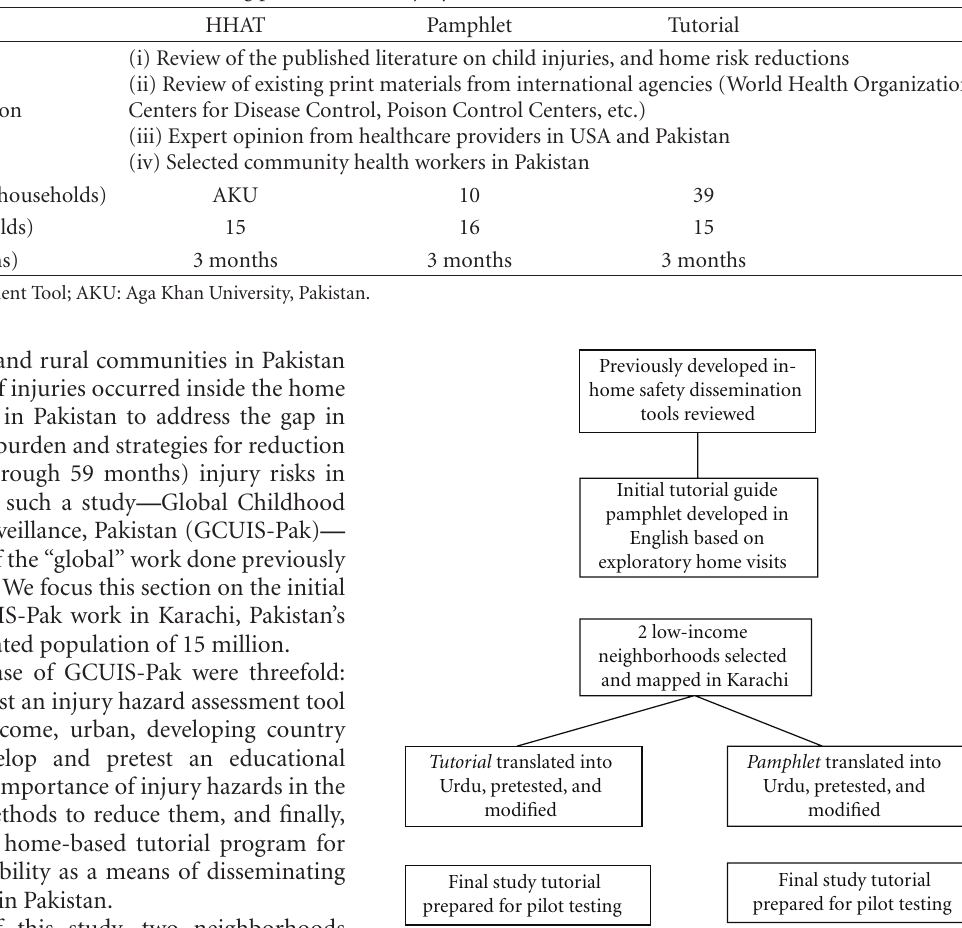
Table 1: Pretesting phase for child injury risk tools in Pakistan.